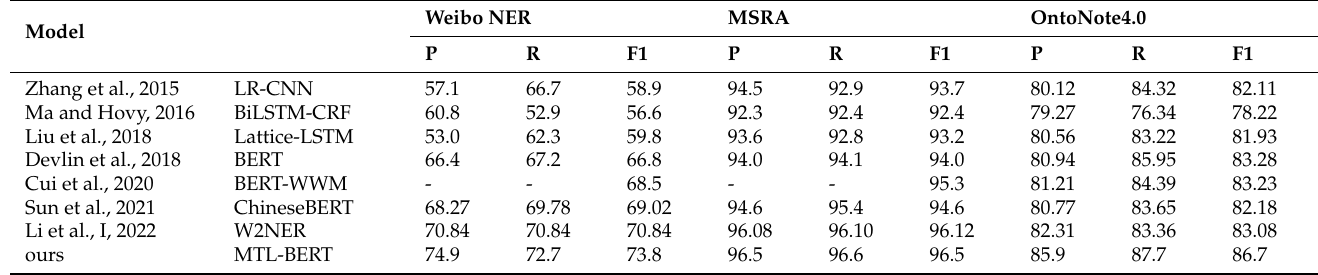
Table 4. Comparative experimental results of Chinese named entity recognition task (%).